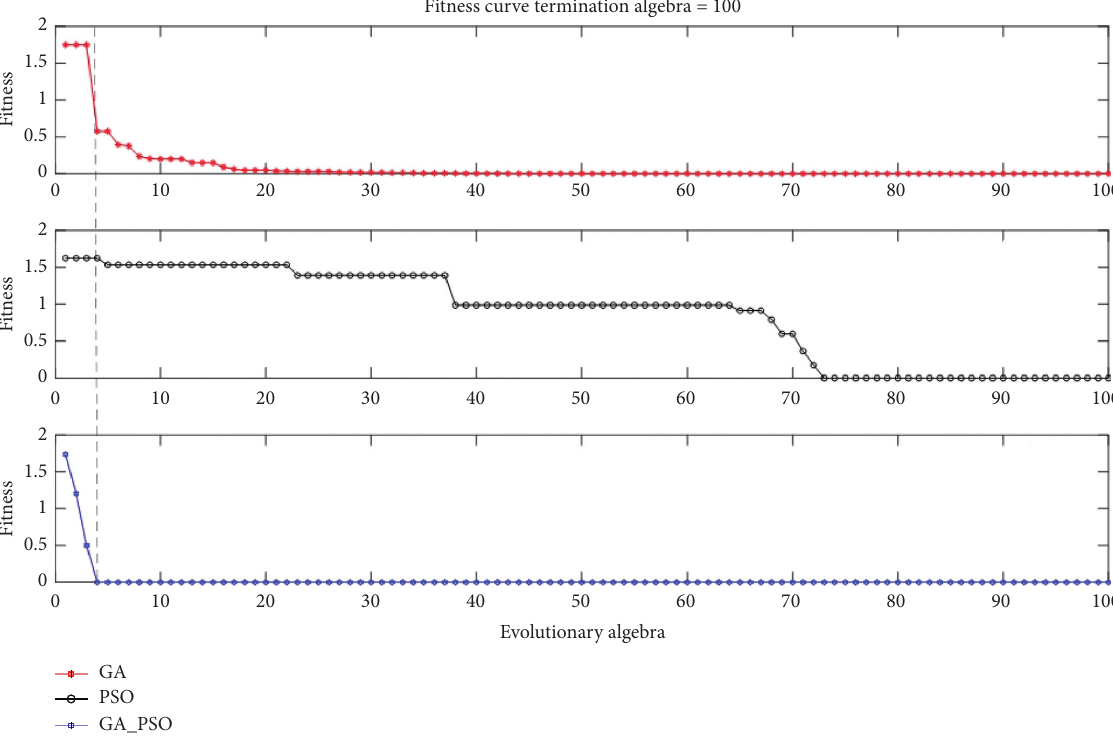
Figure 2: Comparison of fitness curves of three algorithms.